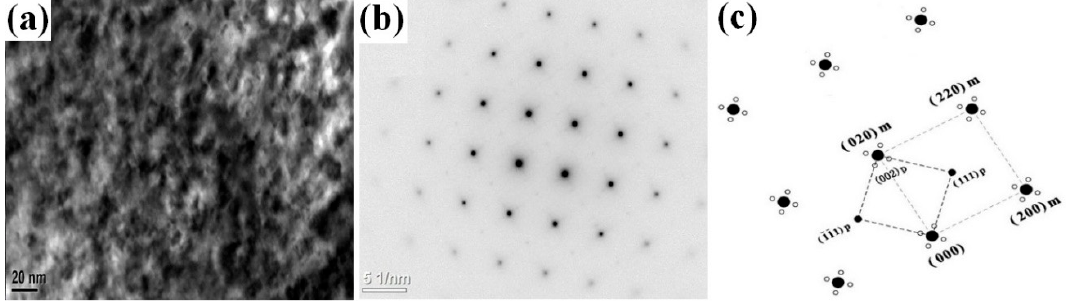
Figure 6. TEM of S1 alloy aged at 500 °C for 4 hours with a zone axis of [001] Cu : ( a ) Bright-image. ( b ) SADP. ( c ) Result of SADP.